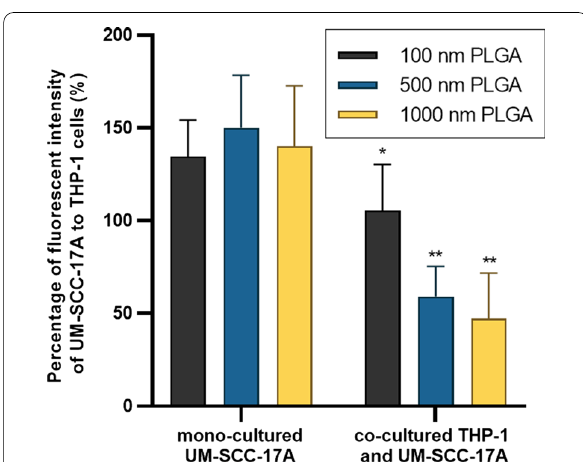
Fig. 7 Quantitative analysis of PLGA particle internalization in UM‑SCC‑17A cells in monoculture and co‑culture systems. The percentage of particle fluorescent intensity in UM‑SCC‑17A cells normalized to that in THP‑1 cells for solely and mixed cultured